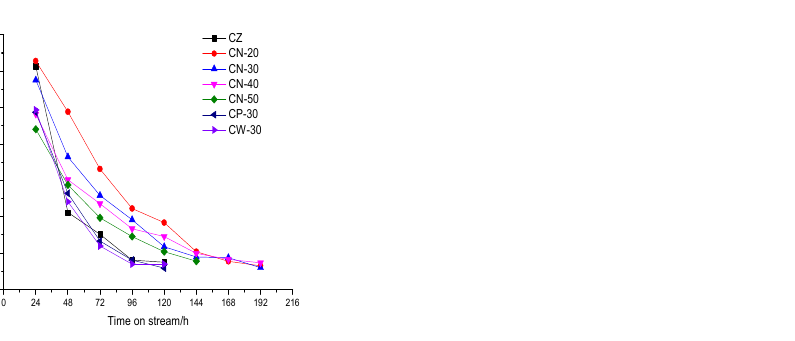
Figure 15. The change in the hydrogen transfer index with time on stream over the catalysts. The results of the coke, C and H content of the coke ‐ deposited catalysts are shown in Table 4. The coke weight loss of CZ is the most, at 27.41%, indicating that its coke depo ‐ sition amount is the largest; additionally, its C/H ratio of coke deposition is the highest, reaching 1.75, while the lowest C/H ratio was of CN ‐ 50, at 1.36. The coke deposition amount of CN series catalysts first increases and then decreases from CN ‐ 20 to CN ‐ 50; CN ‐ 30 has the highest coke deposition amount, which is due to it having the longest lifetime. The C/H ratios of CN ‐ 20, CN ‐ 30 and CN ‐ 40 are the same, 1.53, while the C/H ratio of CN ‐ 50 decreases significantly. The C/H ratio order of the catalysts prepared by the three methods is CP ‐ 30 > CW ‐ 30 > CN ‐ 30. Table 4. The results of the coke, C and H content of the coke ‐ deposited catalysts. Catalysts